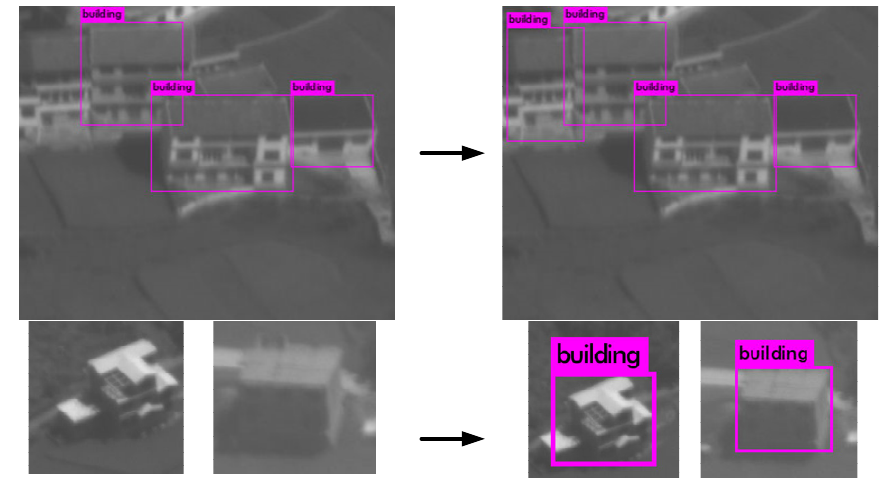
Figure 5. Detection results of dense urban buildings.